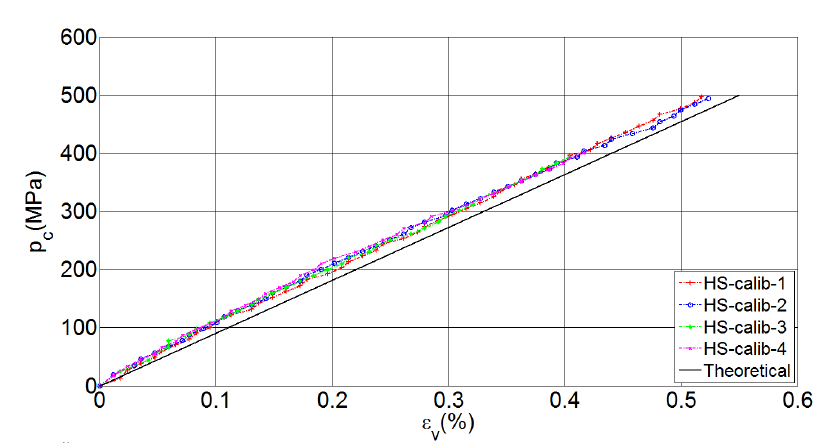
Figure 10. Results of the hydrostatic calibration tests on the HS: p vs. (cid:101) v > 0 in compression.